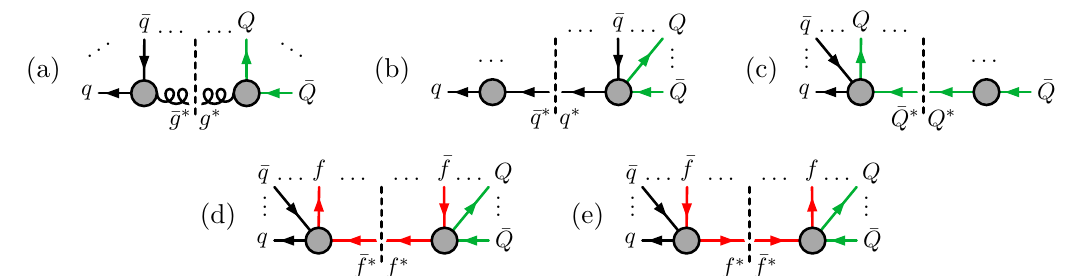
Figure 3 . Factorisation channels of qQ -basis colour-ordered